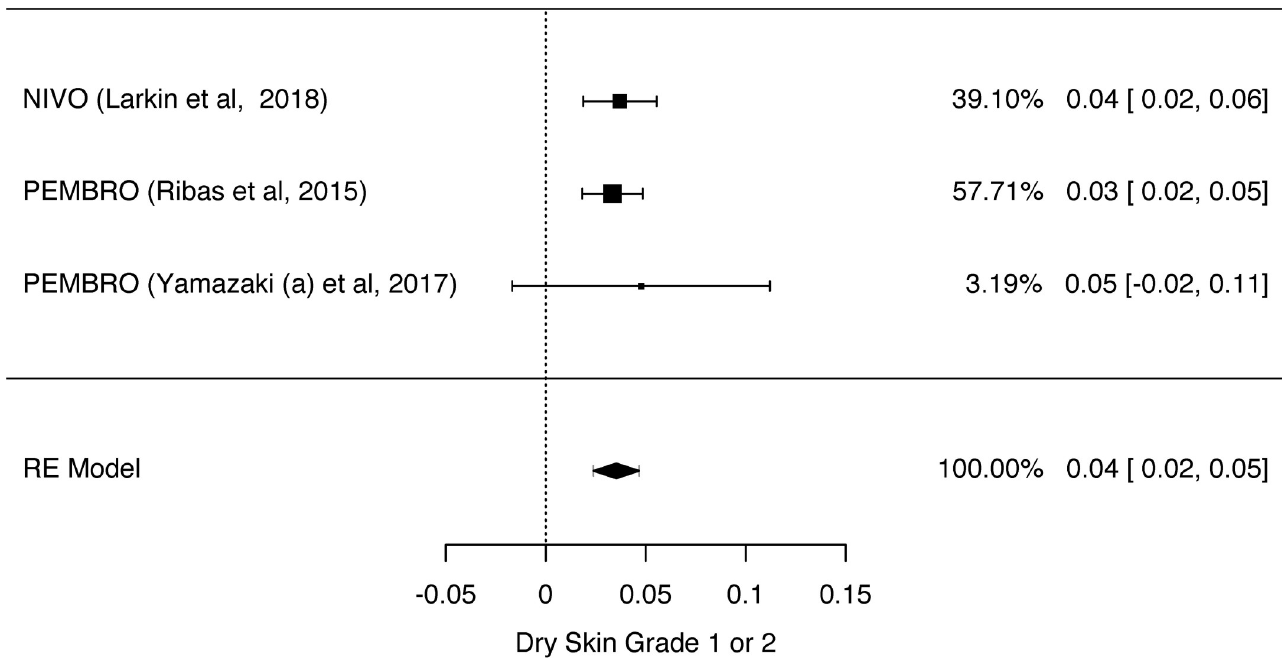
Fig 6. Meta-analysis of dry skin outcome grade 1 or 2. Elaborated by the authors using JAMOVI 1 . Legend: NIVO—Nivolumab, PEMBRO—Pembrolizumab.